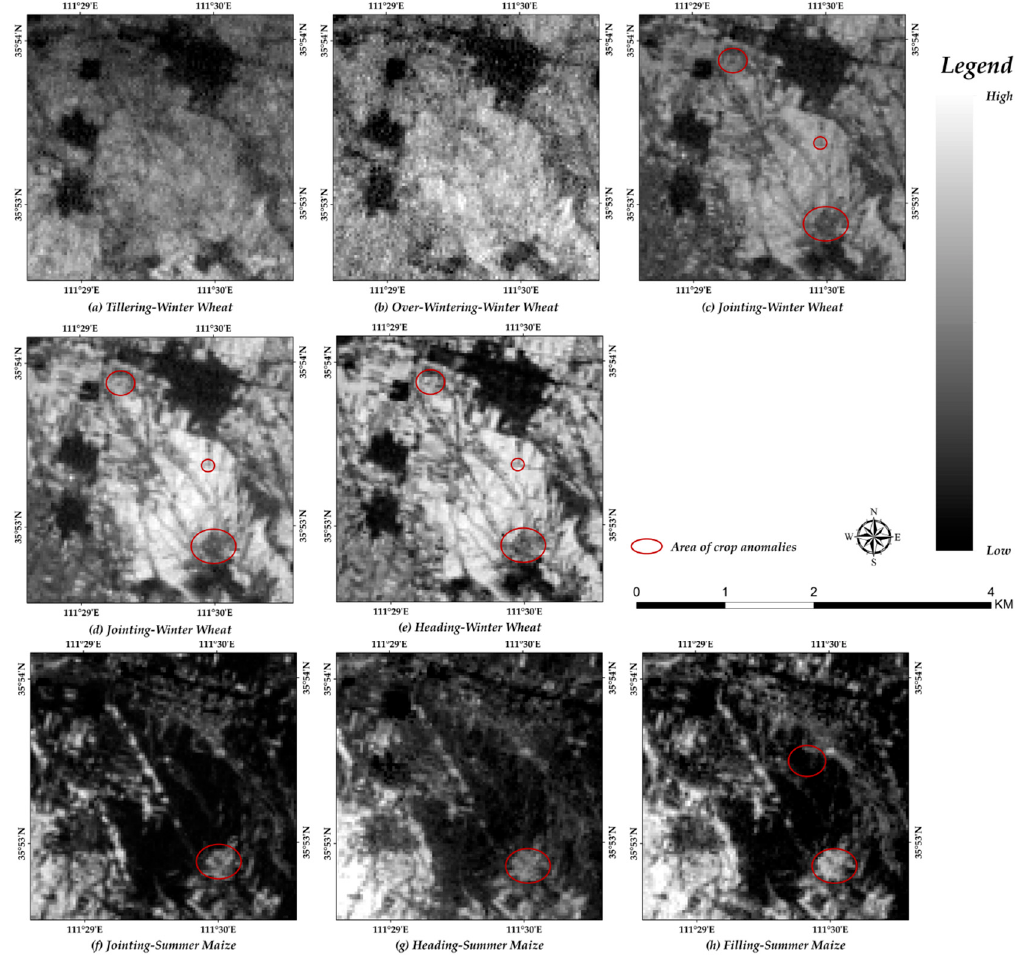
Figure 4. Landsat NDVI time series images from 2000–2001 of Taosi. Winter wheat: ( a ) Tillering (22 November 2000); ( b ) Over-wintering (24 December 2000); ( c ) Jointing (13 March 2001); ( d ) Jointing (30 March 2001); ( e ) Heading (14 April 2001). Summer maize: ( f ) Jointing (4 July 2001); ( g ) Heading (4 August 2001); ( h ) Filling (13 September 2001). The negative crop and positive anomalies caused by the southeast small town of worship and sacrifice can be identified in images ( c – h ), the north sacrificial area and the dense storage area shows negative anomalies in images ( c – e ), and the palace area shows positive anomalies in image ( h ).